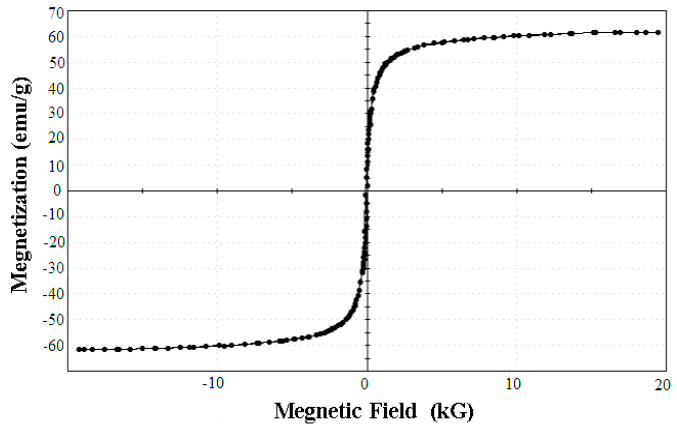
Figure 7. Magnetic hysteresis loops curve of the SPA-coated gold-magnetic nanoparticles functionalized capturing probe.